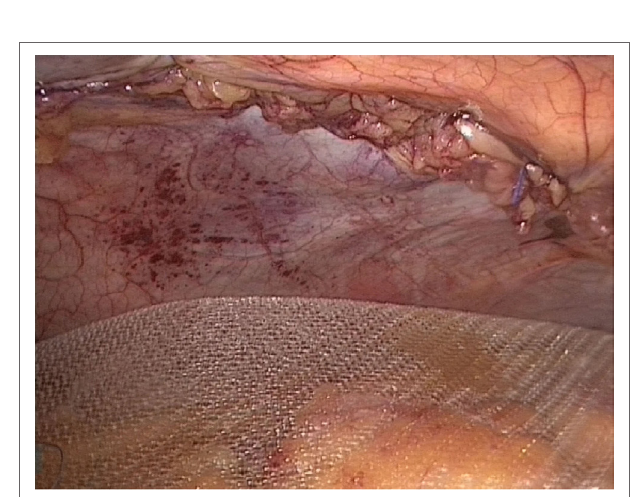
FIgURe 2 | Complete closure of the linea alba prior IPOM mesh implantation.